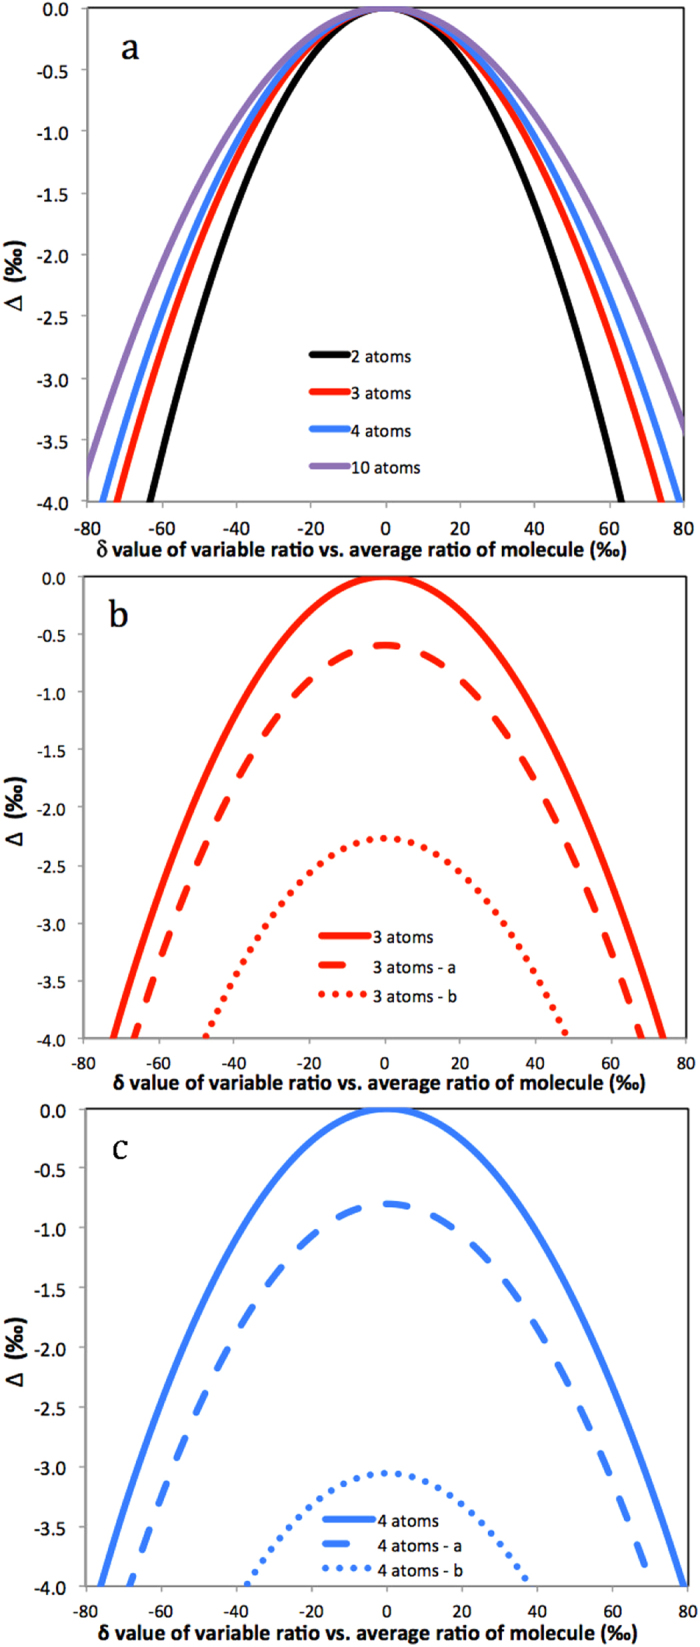
Dependence of the apparent statistical clumped isotope signal for combining two (black), three (red), four (blue) or 10 (purple) indistinguishable atoms in a molecule.In all cases one isotope ratio is varied to produce the relative difference of this ratio from the mean of all isotope ratios (x axis scale). In (a) and the solid lines in (b,c) the other isotope ratios are fixed and identical. This case includes the situation where all isotope ratios are equal and Δ = 0‰. In (b) (for 3 indistinguishable atoms) and (c) (for 4 indistinguishable atoms) the solid lines are the same curves as in (a). The dashed lines show the case where one of the fixed isotope ratios is increased by 5% relative to the others, and the dotted line shows the case where one isotope ratio is increased by 10%.